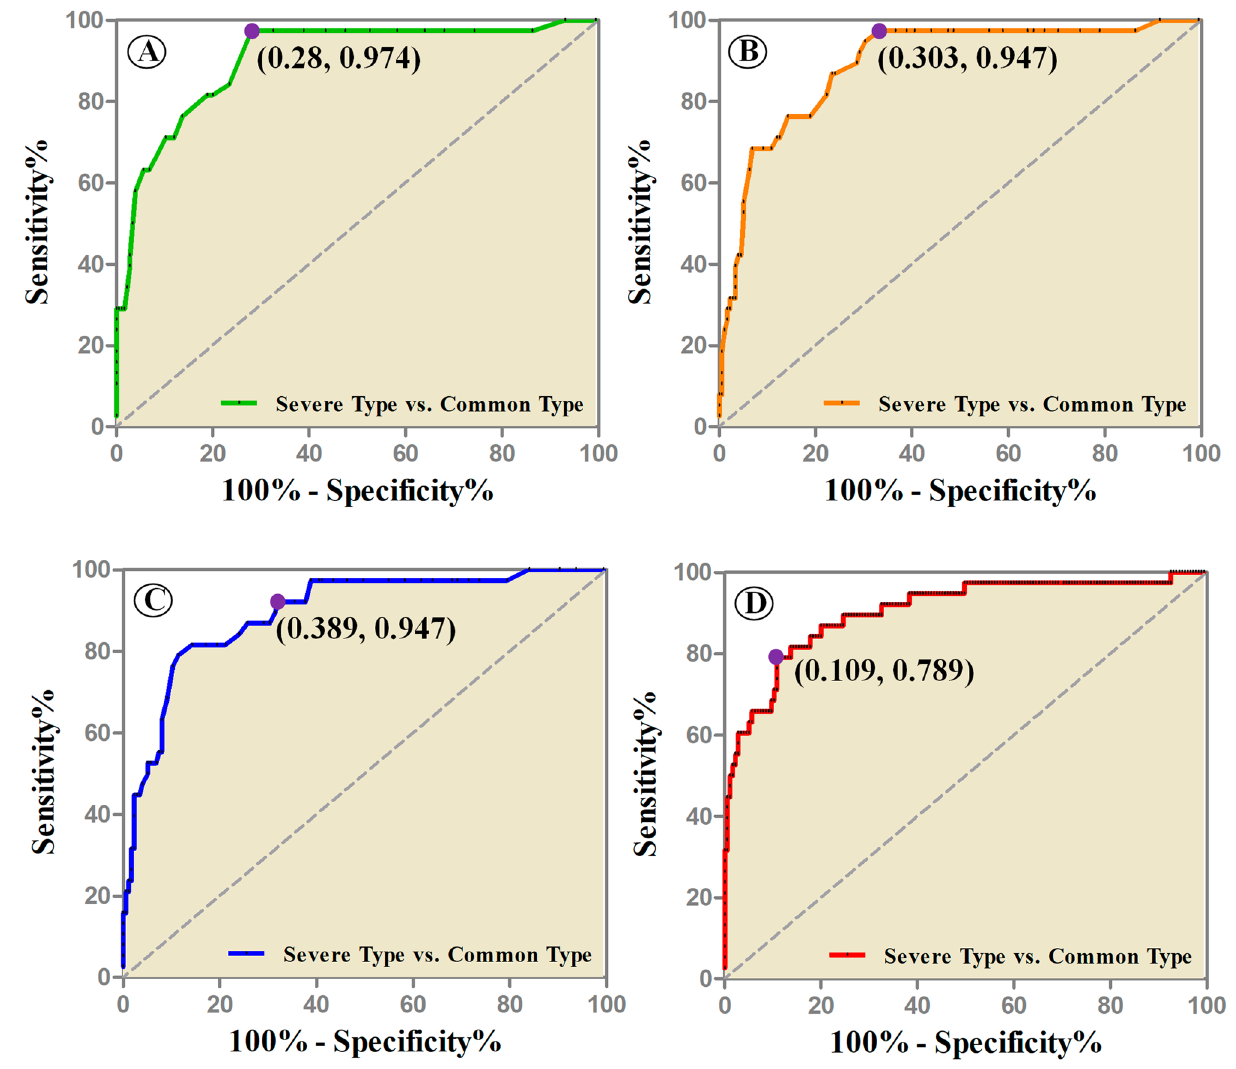
Figure 3. The discriminative efficacy (ROC analysis) of lesion assessments, measured by lobar lesion assessment ( A ), segmental lesion assessment ( B ), opacity-weighted lesion assessment ( C ), and lesion volume quantification ( D ), between severe type and common type patients with